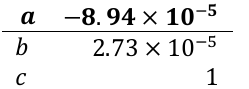
Table 2. Coefficients for ball speed curve from math model with test putter